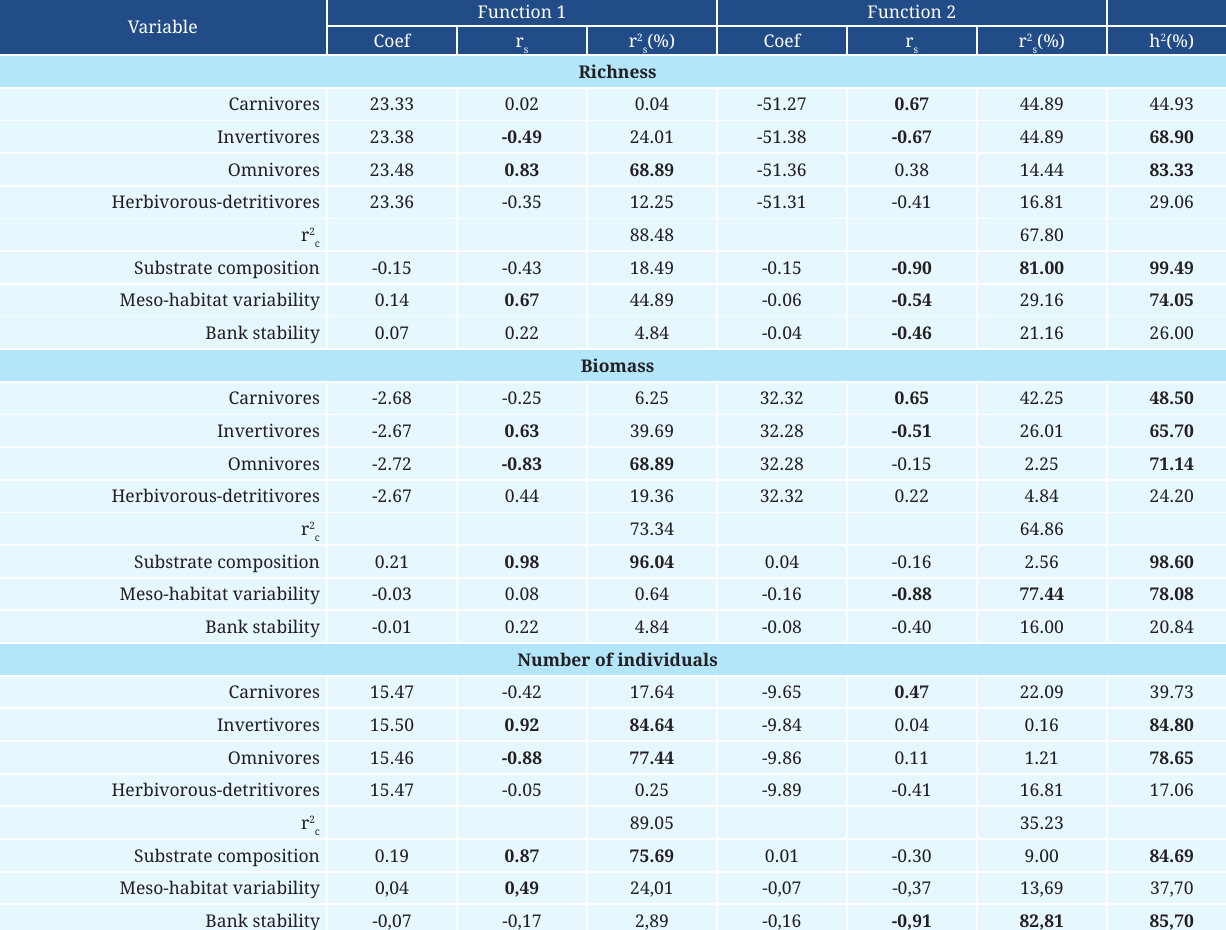
TABLE 4 | Canonical solution for habitat characteristics predicting richness, biomass and number of individuals in each trophic group for Functions 1 and 2. Structure coefficients (r ) greater than |.45| are in bold. Communality coefficients (h 2 ) greater than 45% are also in bold. s Symbols: Coef = standardized canonical function coefficient; r = structure coefficient; r 2 = squared structure coefficient. Functions 1 and s c 2 explained, respectively, 78.07% and 21.41% of the shared variance for richness, 57.08% and 38.31% for biomass, and 90.79% and 6.07% for number of